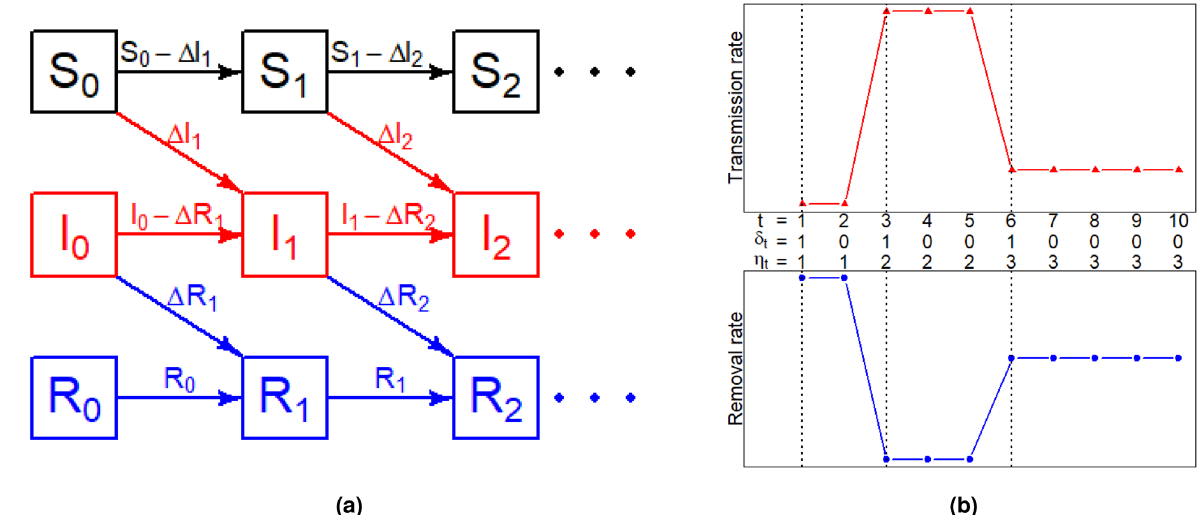
Figure 1. Graphical illustration of ( a ) the update of ( S t , I t , R t ) ; ( b ) change-points in the expected transmission rates and expected removal rates of different